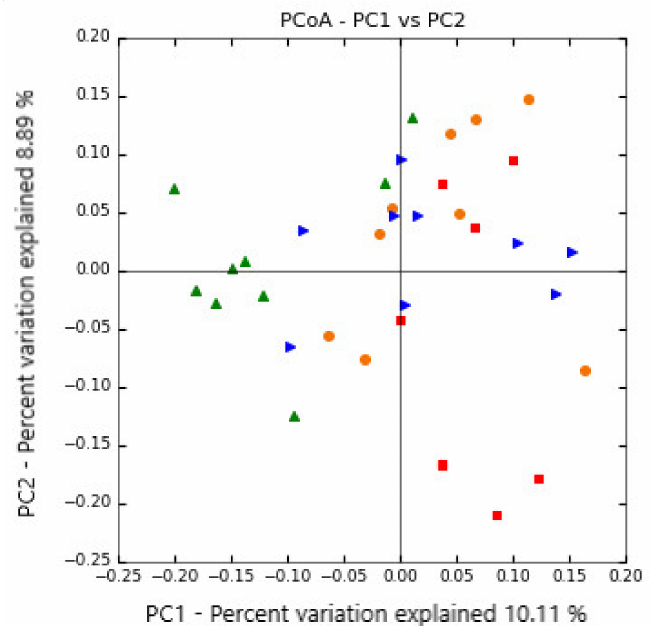
Figure 2. Principal coordinate analysis plot (PCoA) of the Bray-Curtis dissimilarities for the ruminal samples in the control (red square; n = 8), 30 g / kg spent co ff ee grounds (blue triangle; n = 9), 50 g / kg spent co ff ee grounds (orange circle; n = 9) and 100 g / kg spent co ff ee grounds (green triangle; n = 9) groups. The percentage of variation explained by each principal coordinate is indicated on the axes.